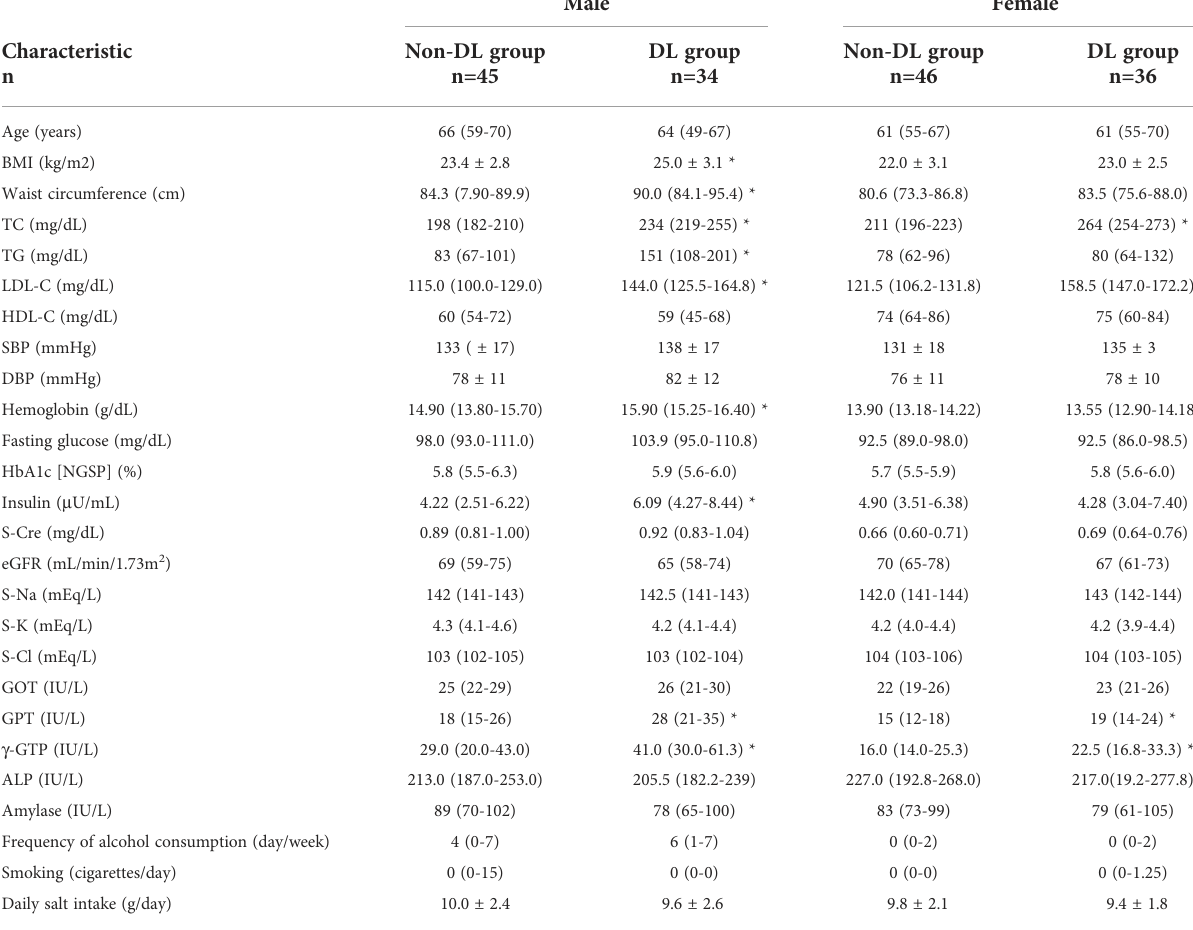
TABLE 2 Characteristics of the study participants classi fi ed based on the presence or absence of dyslipidemia. Male